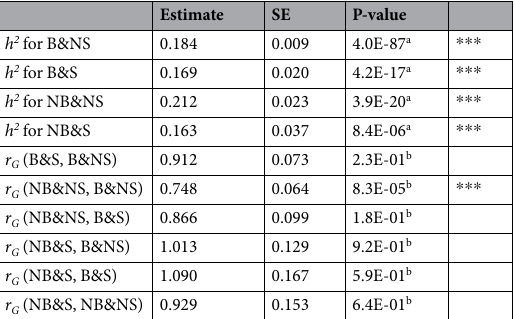
Estimate SE P-value